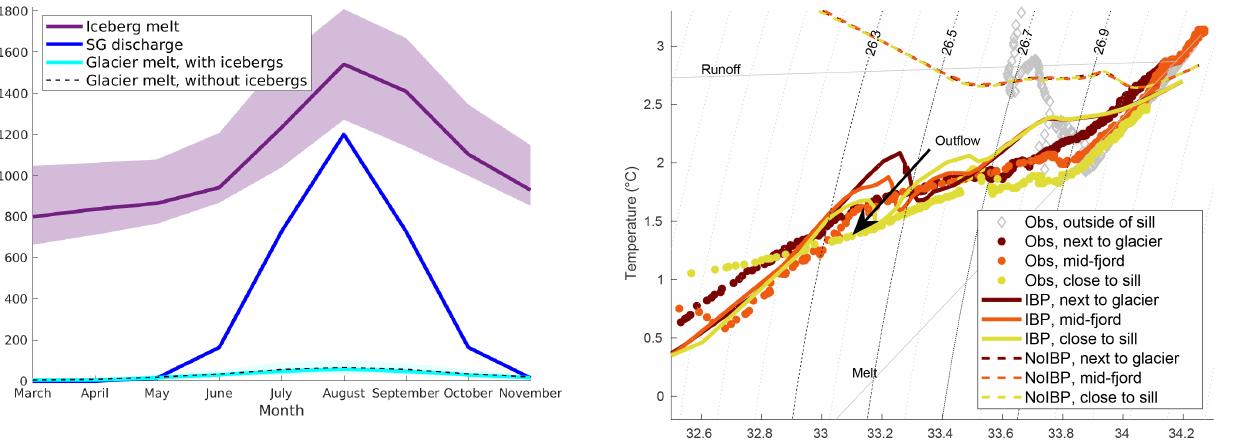
Figure 6. Modelled seasonality of freshwater volume fluxes into Ilulissat Icefjord from three different sources: icebergs (IBP, pur- ple), subglacial discharge forcing (blue line) and glacier melt for NoIBP (dashed black line) and IBP (pale blue). Shadings indicate the range covered by the sensitivity experiments (see Table 1 and Sect. 4.4).